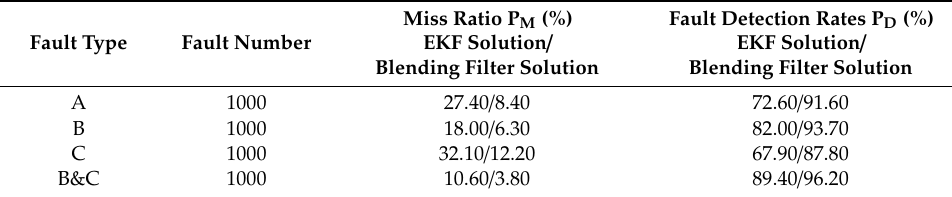
Table 2. Fault detection rates test.